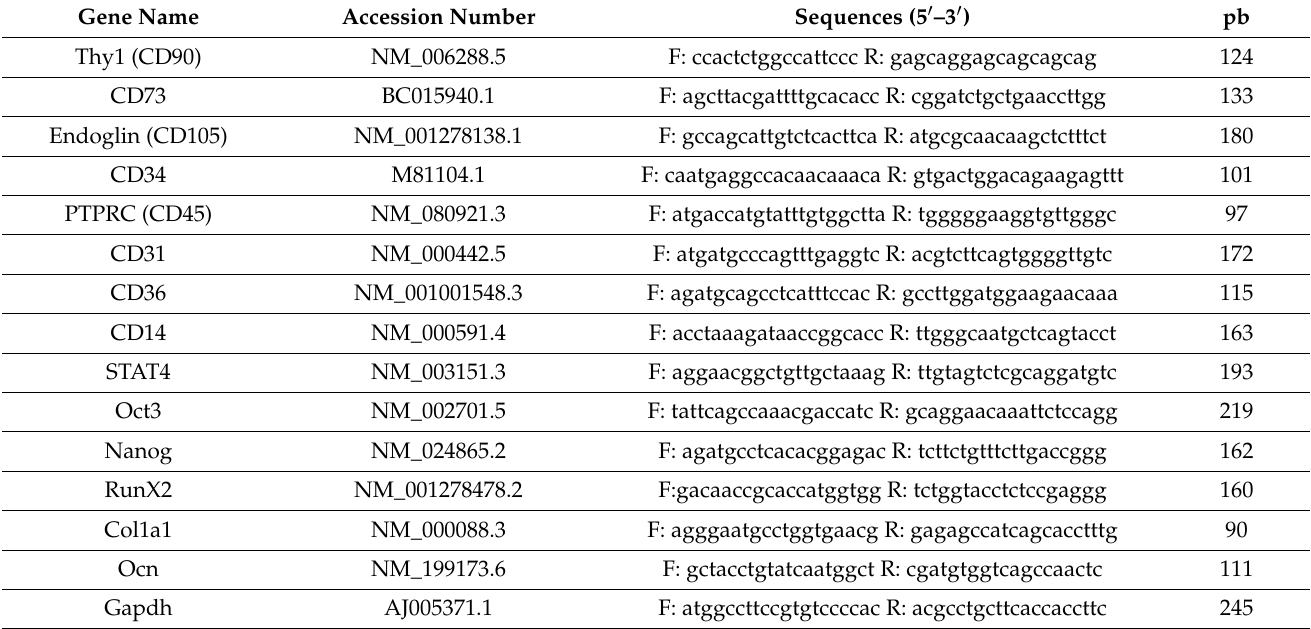
Table 3. Oligonucleotides used for real-time PCR